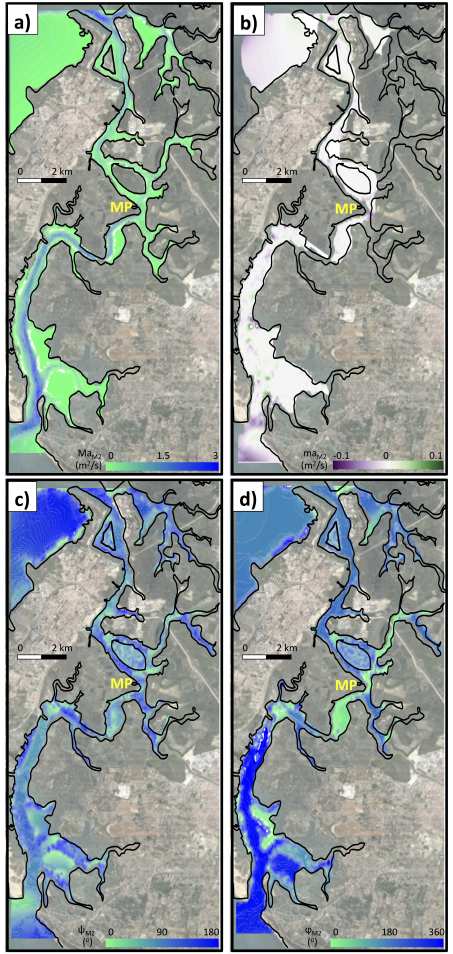
Figure 9. Tidal ellipse parameters of the flow rate. The semi-major axis M a m a (m 2 /s), inclination ϕ M 2 (0 ◦ E–90 ◦ N) and phase φ M 2 ( ◦ ) fields are shown in panels ( a – d ), M 2